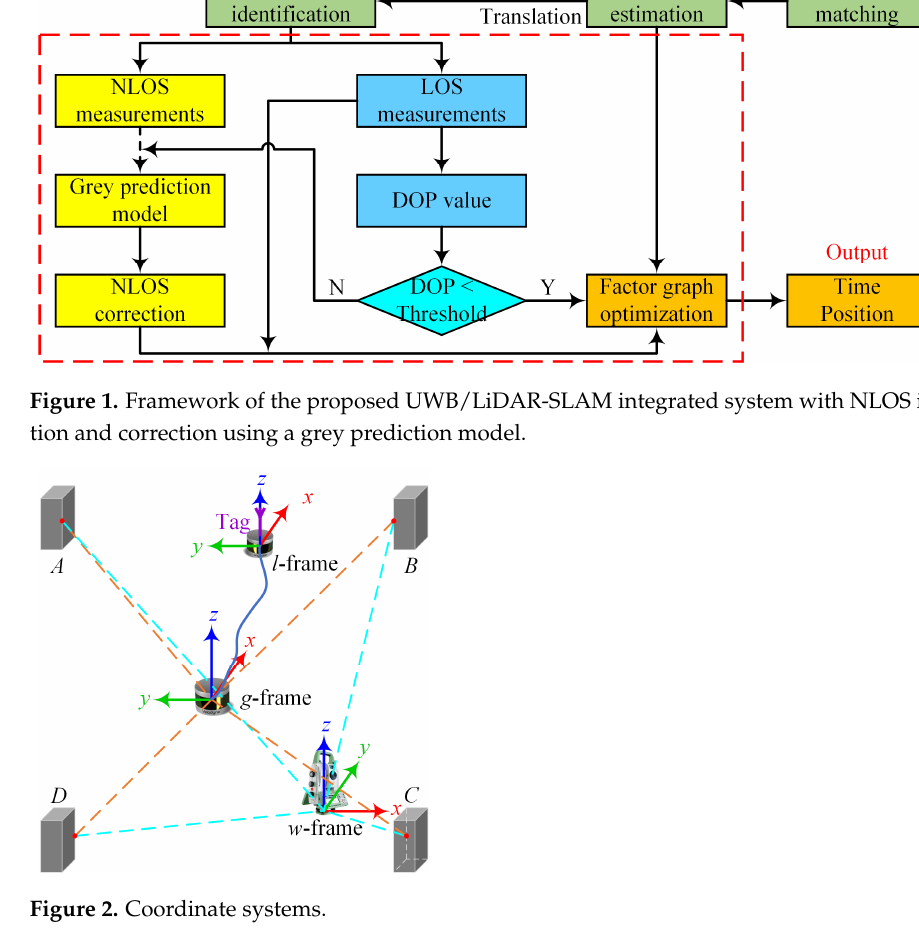
Figure 1. Framework of the proposed UWB/LiDAR-SLAM integrated system with NLOS identifi- cation and correction using a grey prediction model.